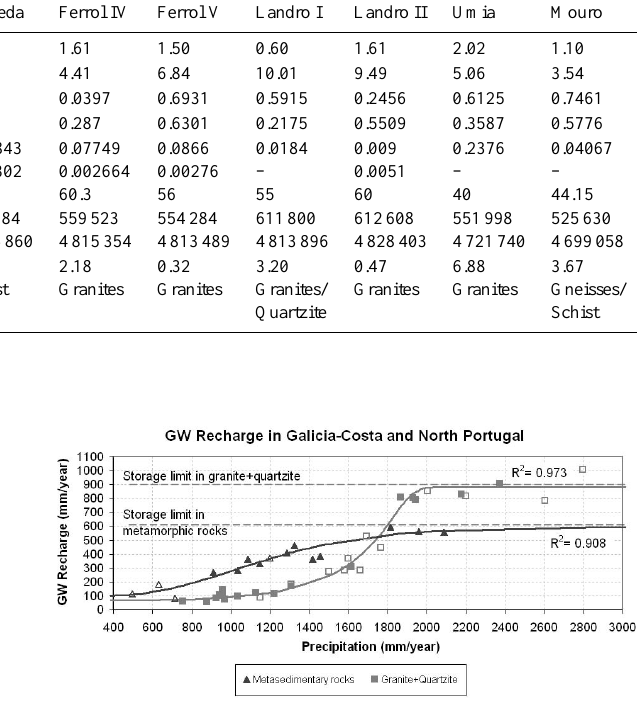
Table 1. Main parameters changed during the calibration process of the hydrological model and UTM coordinates of watersheds outlets. Parameter Gafos L´erez Soil thickness (m)